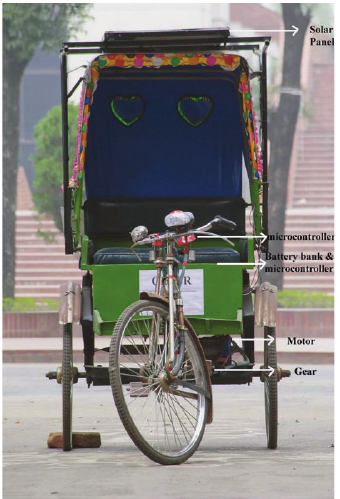
Figure 2: Photograph of the proposed